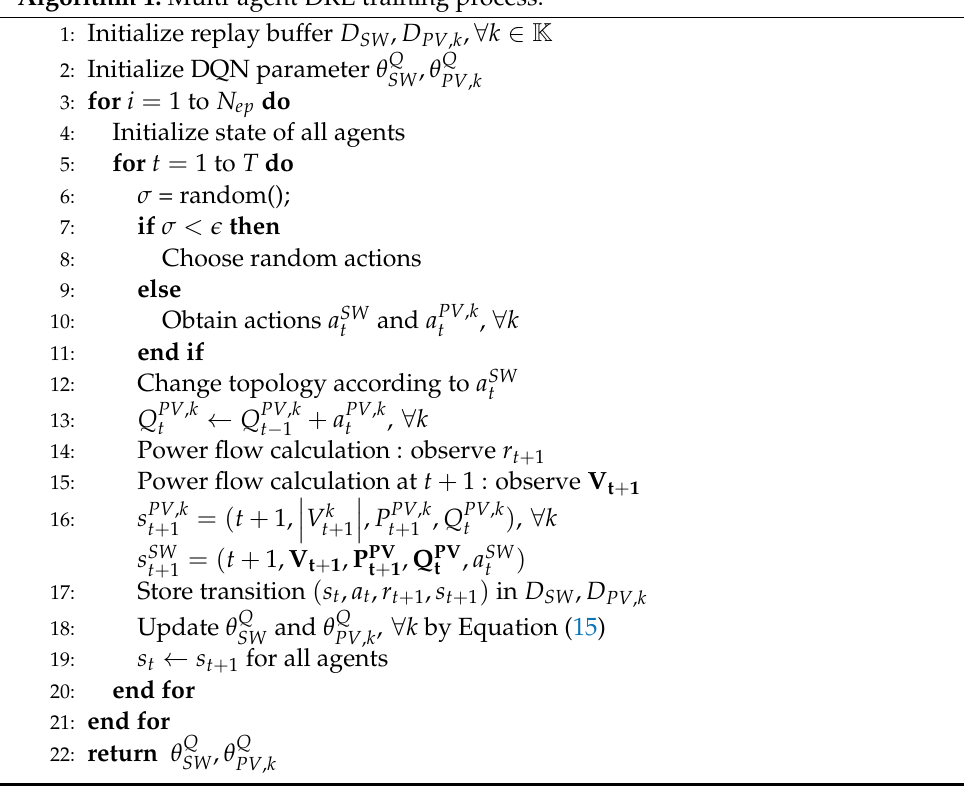
Algorithm 1: Multi-agent DRL training process.